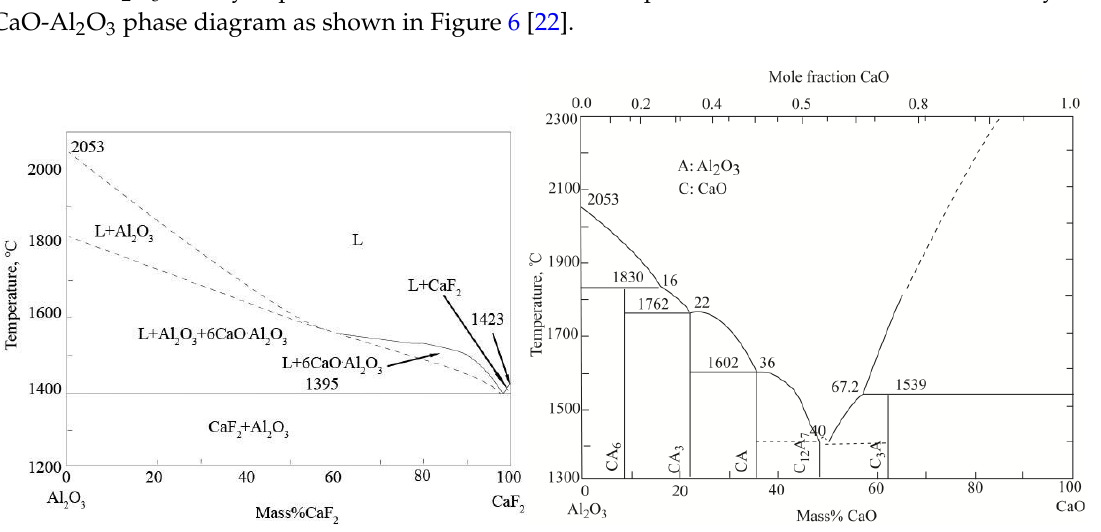
Figure 6. Binary phase diagram of CaF 2 -Al 2 O 3 and CaO-Al 2 O 3 .